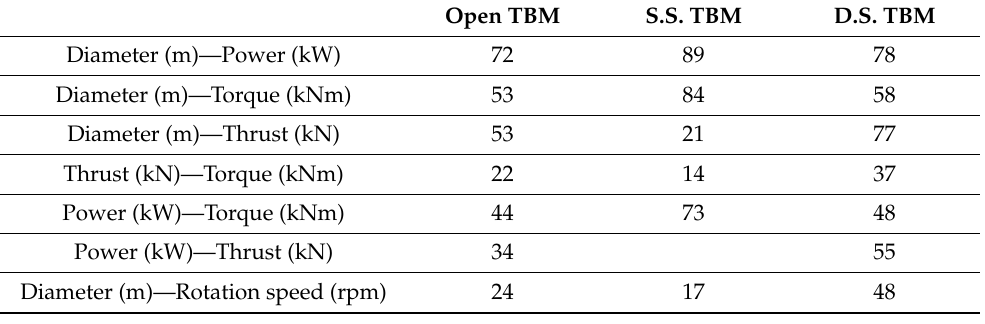
Table 1. Number of cases found in the literature to compare the main parameters of the Tunnel Boring Machines (TBM) analyzed. S.S.: single shield; D.S.: double shield.